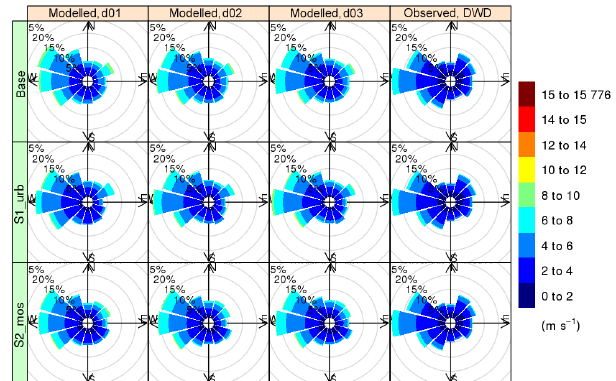
Figure 8. Wind roses over observed and modelled values for JJA, including observations and model results for three stations in Berlin (Tegel, Schönefeld and Tempelhof) and from all three model do- mains (d01 – 15km horizontal resolution, d02 – 3km, d03 – 1km). The bars refer to the frequency of how often wind was coming from the respective direction and the colours indicate how often the wind speed was observed or modelled in the indicated interval.